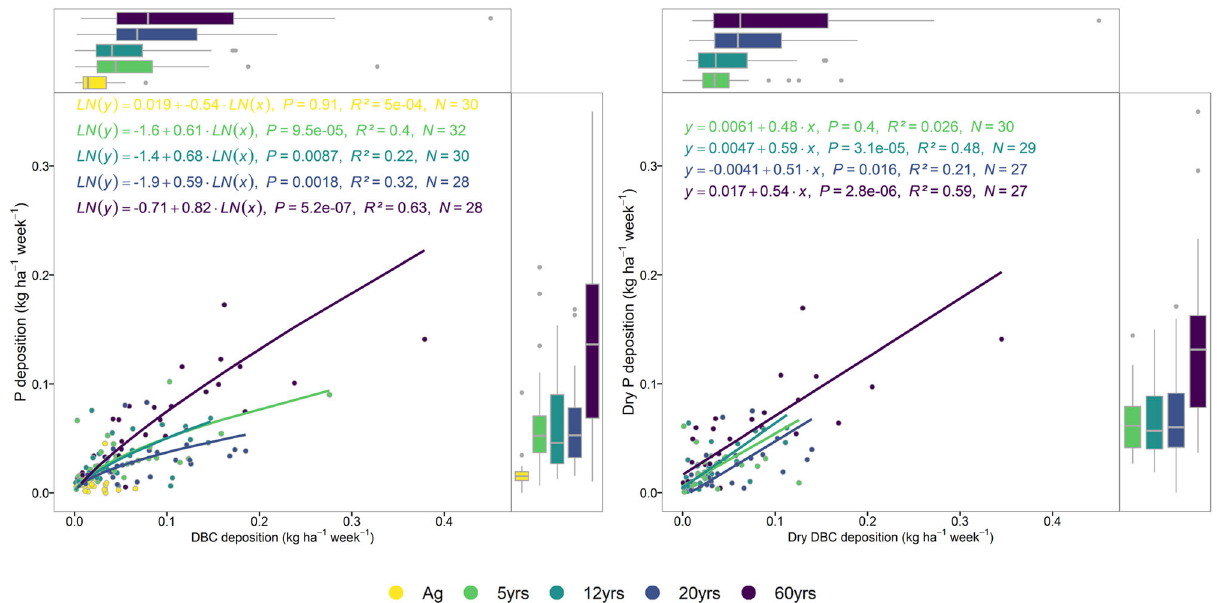
Fig. 1 Weekly total phosphorus deposition versus dissolved black carbon deposition (DBC deposition) and dry P deposition versus dry DBC deposition along successional stages of central African forests: agricultural fi eld (Ag), 5- (5 yrs), 12- (12 yrs), 20- (20 yrs), and 60-year-old forest (60 yrs). Boxplots show the median, the 25th, and 75th percentile and the 1.5 interquartile range spread. Points represent individual, weekly, measurements of composite samples ( n = 8) per plot for each successional